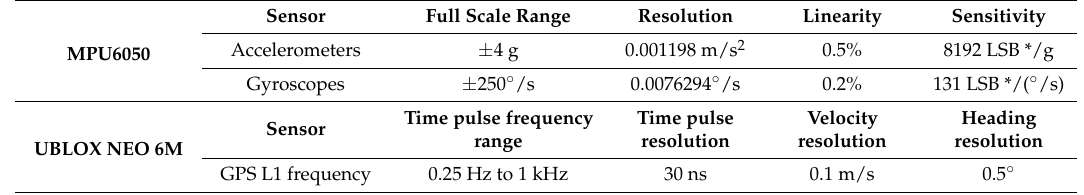
Table 2. Main technical specifications of MPU 6050 and Ublox